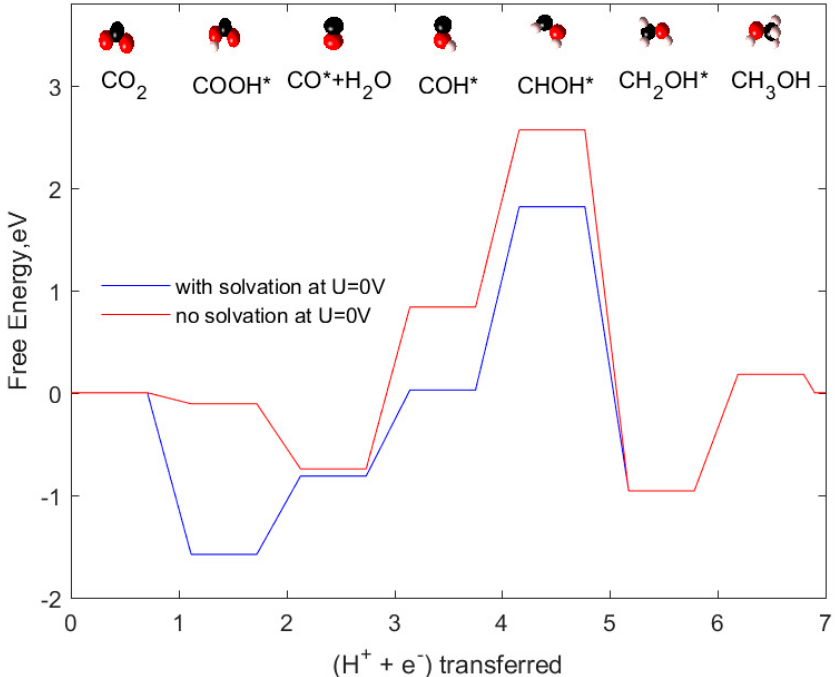
Figure 4. Lowest energy pathways of CO 2 reduction to CH 3 OH on the WC/graphene. Blue pathway: including solvation energy correction factor. Red pathway: without solvation energy correction factor. Color code of atoms: red: oxygen, black: carbon, white: hydrogen.